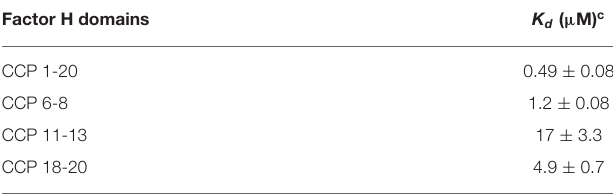
TABLE 3 | Affinity a of Factor H polyanion binding sites b for